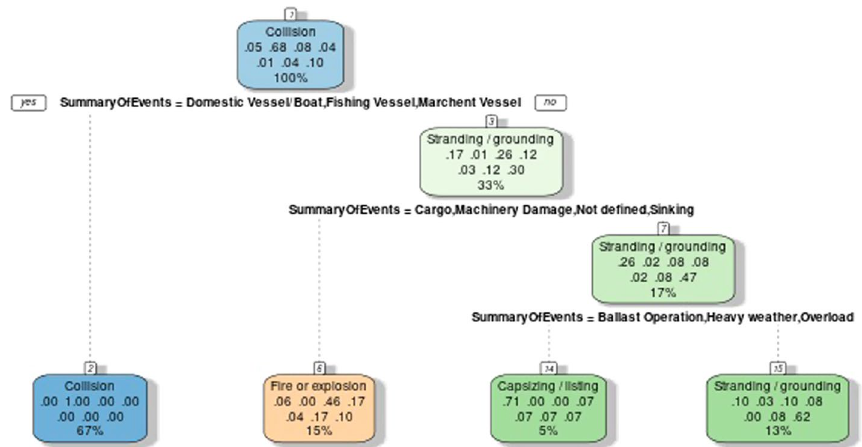
Fig. 5 Decision tree of the different types of casualties with